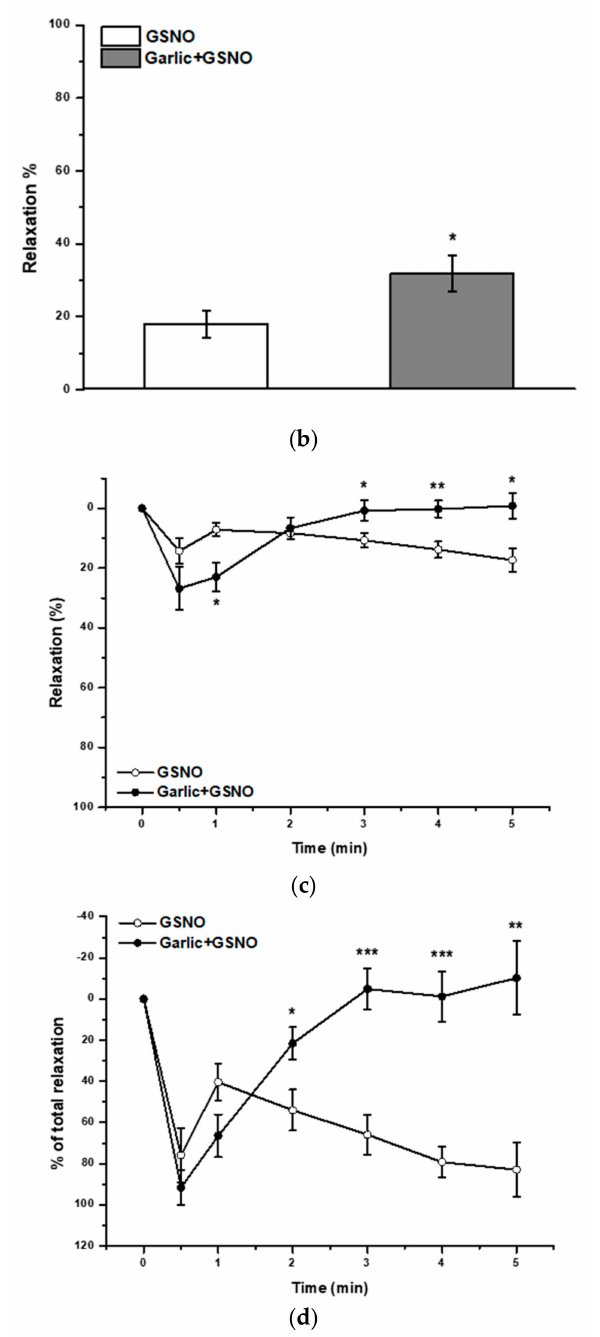
Figure 2. The comparison of the vasorelaxation induced by S-nitrosoglutathione (GSNO) alone and after incubation with garlic juice. Original record of the incubation with garlic juice ( a ). The comparison of the maximal relaxation ( b ) and the absolute ( c ) as well as the relative ( d ) relaxation in time induced by GSNO (0.05 µ M) alone and by GSNO (0.05 µ M) after incubation of precontracted aortic rings with garlic juice (45 ug / mL) ( n = 9). Values are mean ± S.E.M. * p < 0.05; ** p < 0.01; *** p < 0.001 with respect to the value of the GSNO